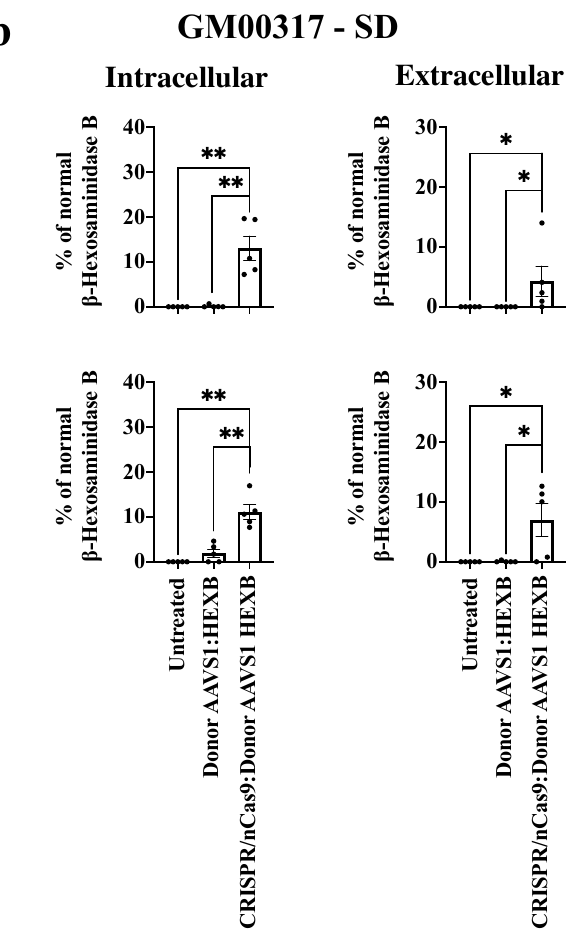
Figure 2. Short- and medium-term genome editing on GM2 fibroblasts. ( a ) Intracellular Hex A enzyme activity for TSD fibroblasts 7 and 15 days post-edition ( n = 4). ( b ) For SD fibroblasts, the intra- and extracellular Hex B activity are shown in the left and right panels, respectively ( n = 4). * p ≤ 0.05, ** p ≤ 0.01, **** p ≤ 0.0001. Mann–Whitney U